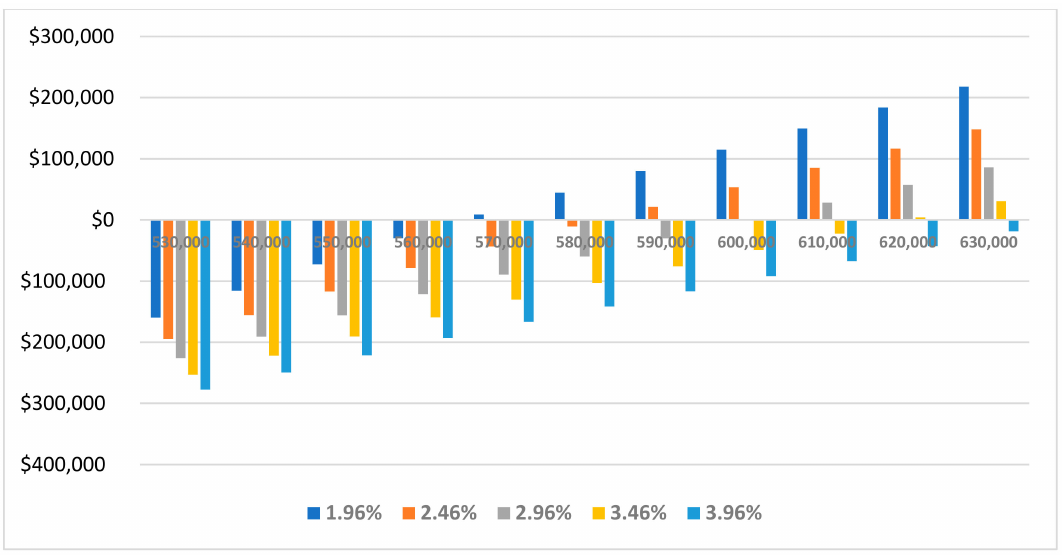
Figure 4. NPV of social discount rate changes in 2 berths.